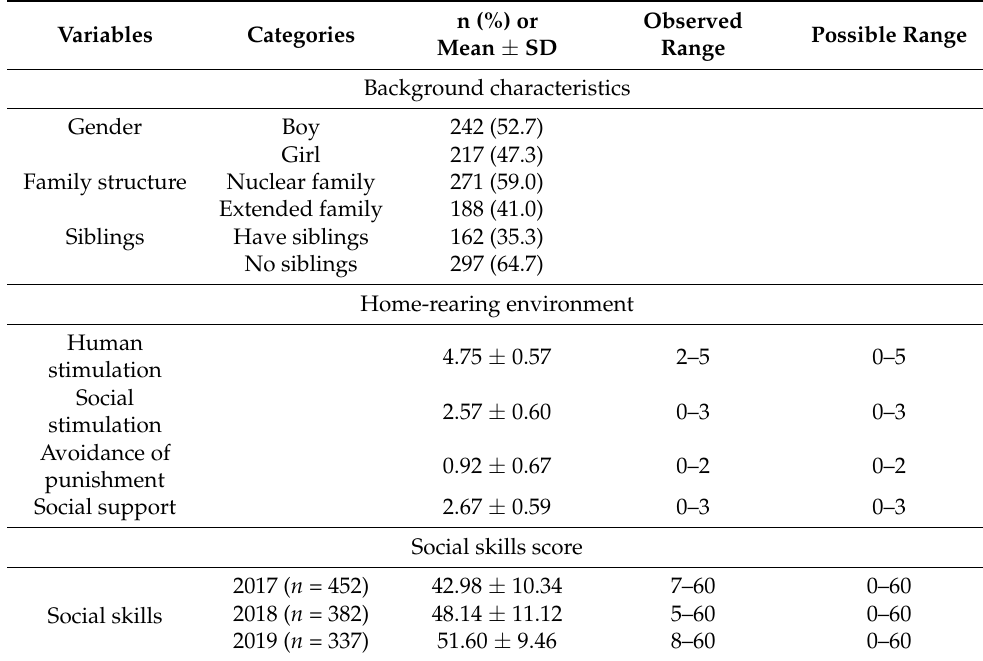
Table 1. Descriptive statistics of the study sample.